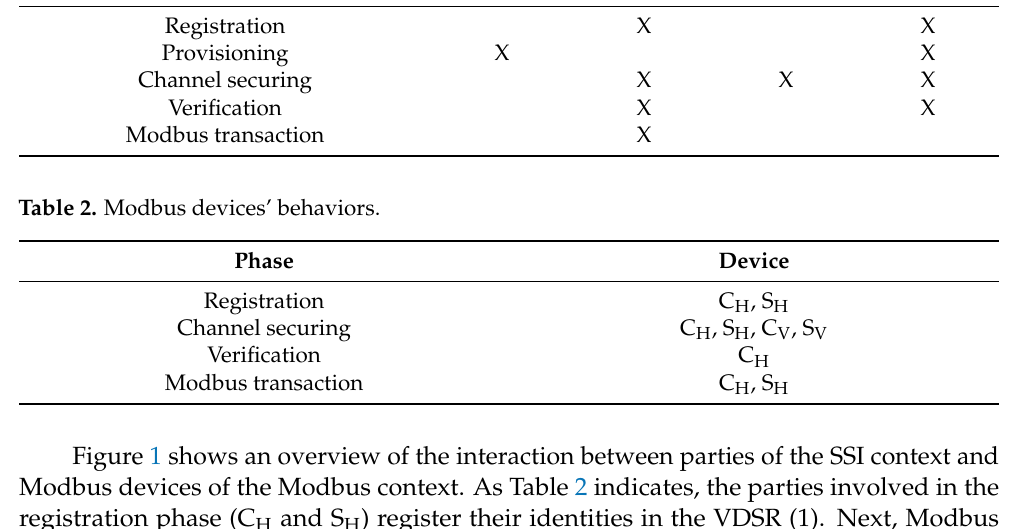
Table 1. Participation of SSI parties on mbapSSI’s phases.